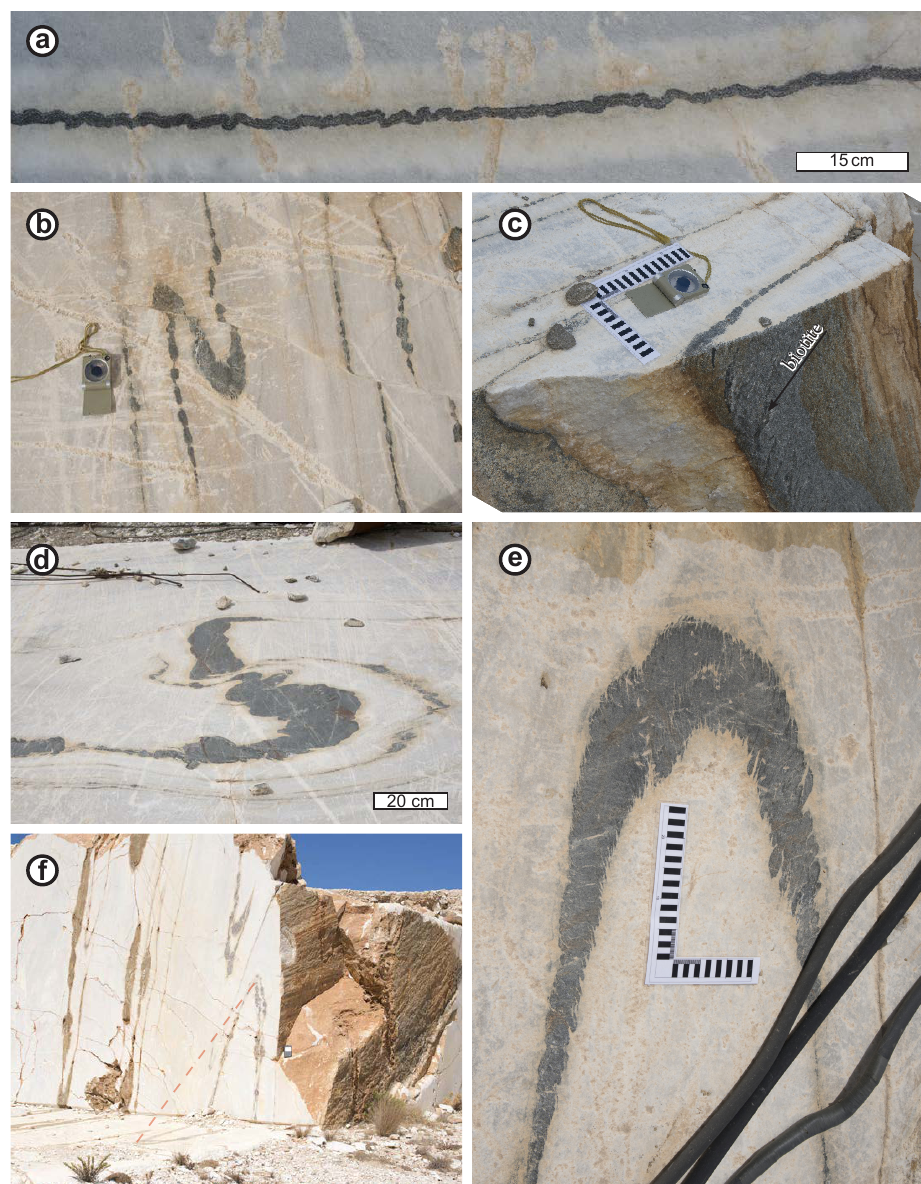
Figure 6. (a) Rare example of small-scale concentric open folds in an amphibolite layer. Much more common in the field area are asymmetric isoclinal folds. (b) Isoclinal S fold displaced by a late E–W-trending oblique-slip fault. Both S and Z chiralities of folds are found in the study area. (c) Fold axis orientations vary strongly (see also Fig. 4); here the axis plunges steeply to the north. The layer-parallel cut of the limb exposes accumulations of biotite associated with the fold. (d) S fold with multiple parasitic folds and increased amphibolite thickness in the limb (view to the west). Bright east–west-trending hairline veins are parallel in the fold limbs and reef and not necessarily orthogonal to the amphibolite layer. (e) Cuspate–lobate amphibolite–marble interfaces form foliation fans in some fold hinges. (f) South-dipping fold axis (dashed red line) in Location 15. The apparent lineation on the thin exposed amphibolite layer (above the fieldbook) is parallel to lλ